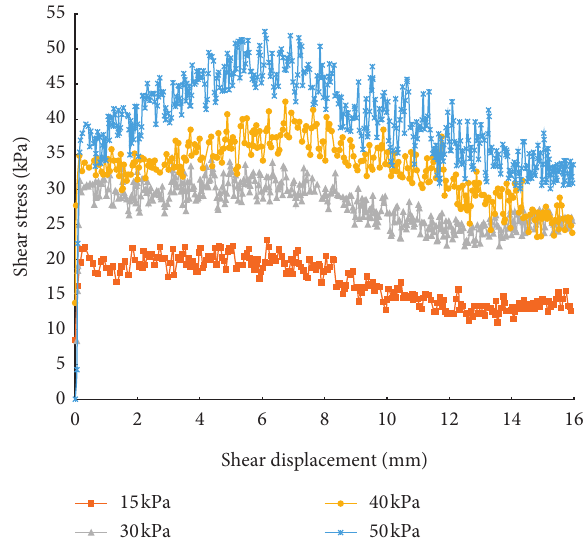
Figure 9: Shear stress-shear displacement curve of 0.2 cm horizontal ring-shaped-reinforced sand.